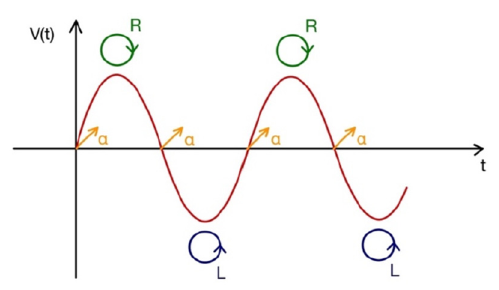
Figure 2. Sketch of the polarization of the light beam after the PEM, for an applied voltage value such that the phase shift is ∆ ϕ = π /2. The red curve represents (vs. time) the voltage driving the PEM at the frequency ν 0 . At V = 0 volt, the polarization is linear, here directed as α (yellow arrows). When the voltage reaches its maximum, the resulting polarization is circular and right handed (green circles). When the voltage reaches its minimum, the resulting polarization is circular and left handed (blue circles). The oscillation frequency of the signal between the two states of circular polarization is evidently ν 0 . The frequency of the linearly polarized signal is 2 ν 0 .